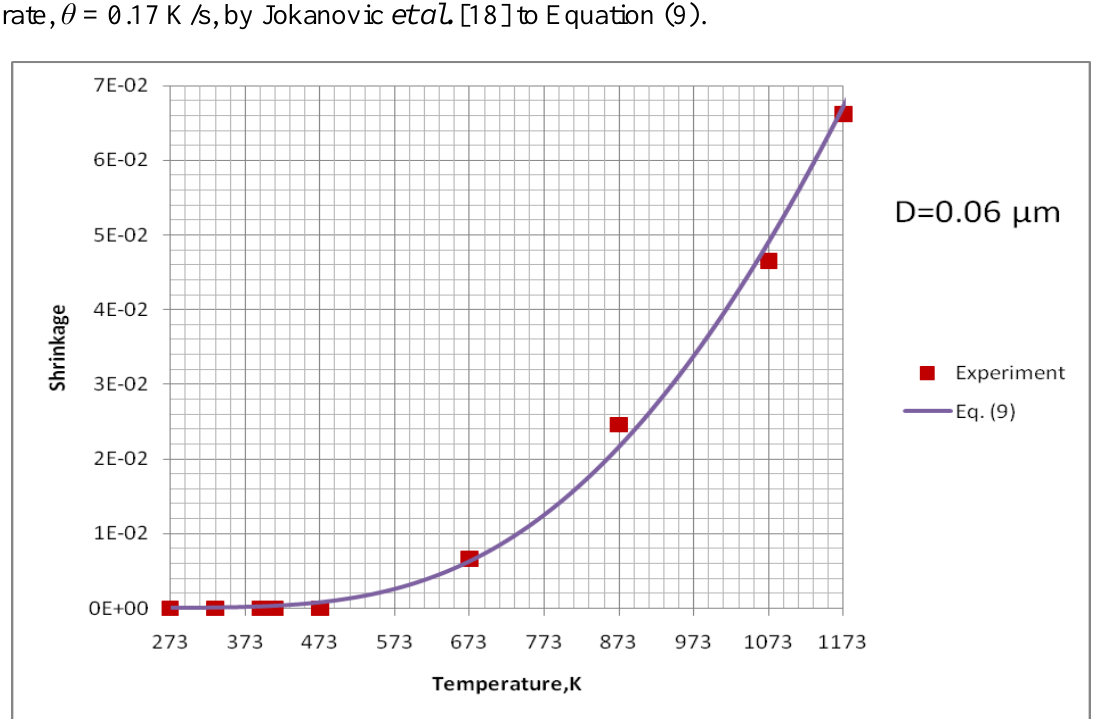
Figure 12. Fitting of experimental points obtained for shrinkage of HA at constant heating rate, θ = 0.17 K/s, by Jokanovic et al. [18] to Equation